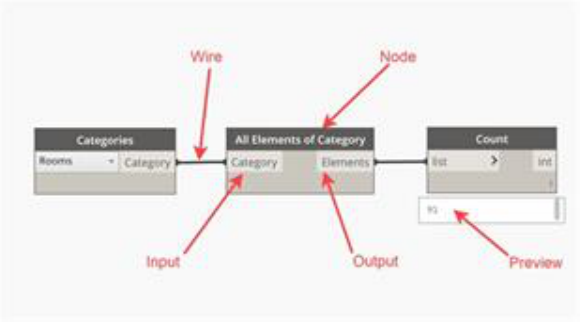
Figure 4 . The interface of Dynamo. (source: